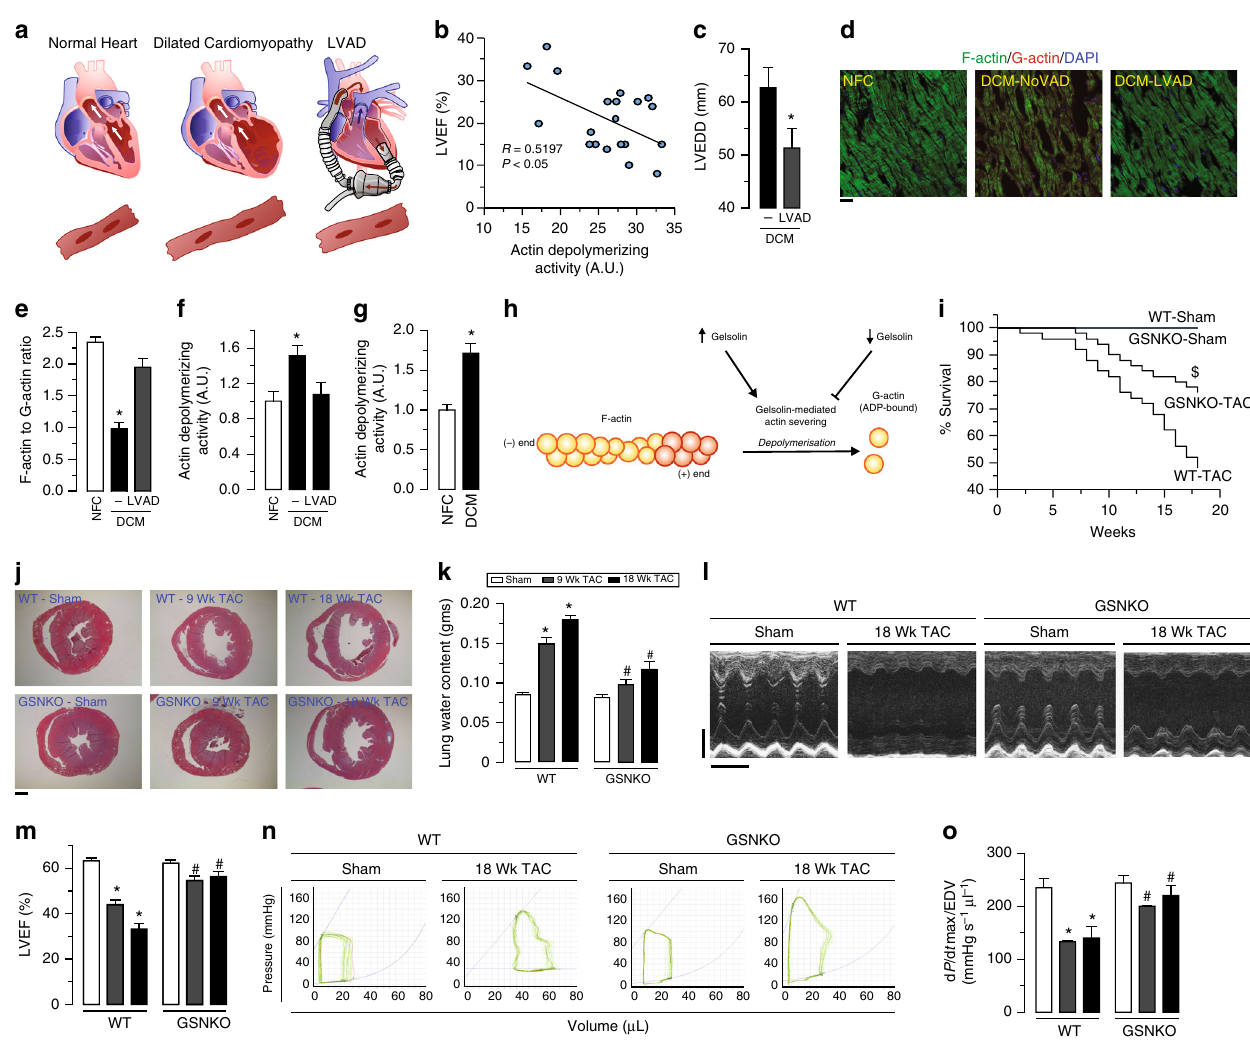
Fig. 1 Relationship between gelsolin and adverse cytoskeletal remodeling in DCM and in biomechanical stress-induced HF. a Schematic showing pathogenic and reverse remodeling process. Pathogenic remodeling in response to chronic injury leading to ventricular dilation, resulting in HF with reduced EF. LVAD placement results in reverse myocardial remodeling and improved cardiac function. b LVEF inversely correlates with myocardial gelsolin actin-depolymerizing activity in humans with DCM; n = 20 DCM hearts; age 52.3 ± 2.49 y; 16 male/4 female. c LV end-diastolic dimensions (LVEDD) from patients with DCM showing cardiac reverse remodeling in response to LVAD placement. d – g Representative images of F- and G-actin staining ( d ), F-actin to G-actin ratio ( e ), and actin-depolymerizing activity in human ( f ) and canine ( g ) hearts showing increased actin depolymerization in DCM samples compared with NFC. LVAD placement reduced actin-depolymerizing activity and recovered F to G-actin ratio. h Schematic showing the role of gelsolin in actin depolymerization. i Kaplan – Meier survival curve showing markedly increased mortality in response to pressure overload for 18 weeks in WT mice. Loss of gelsolin signi fi cantly decreased mortality in response to pressure overload. j Masson trichrome staining showing increased ventricular dilation in WT mice, which was attenuated in GSNKO mice. k Lung water content showing increased pulmonary edema in pressure-overloaded WT mice, which was attenuated in the GSNKO mice. l – o M-mode echocardiography images ( l ), quanti fi cation of LVEF ( m ), representative PV loop images ( n ), and d p /d t max /EDV (load-independent index of systolic function; o ) showing severe HF with EF in WT mice in response to pressure overload-induced biomechanical stress. Loss of gelsolin markedly preserved cardiac function. Data represent means ± s.e.m. * P < 0.05 compared with the respective control groups (NFC or Sham), # P < 0.05 compared with respective WT — 9 Wk or 18 week TAC group as determined by unpaired two-tailed Student ’ s t test ( c , g ) and one-way ANOVA analysis ( e , f , k , m , o ). $ P < 0.05 for Kaplan – Meir survival analysis ( i ) as determined by log-rank test. Biological replicates: n = 20